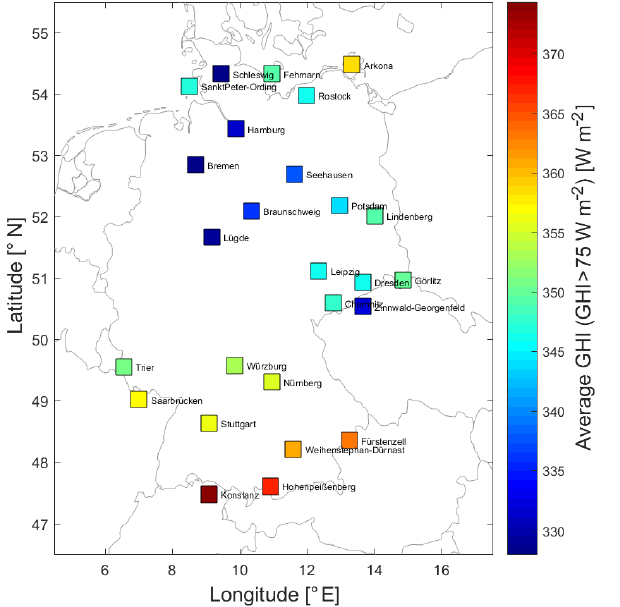
Figure 2. Map of the average for the period 2010–2018 of the 10- min average of irradiance (GHI) at the 26 selected